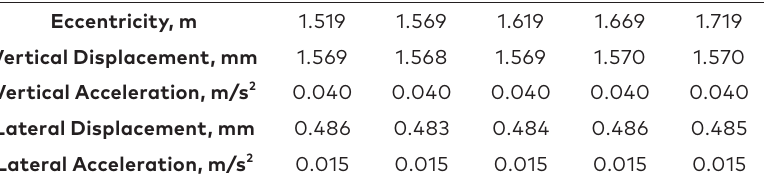
Table 6. Peak dynamic response of vehicle